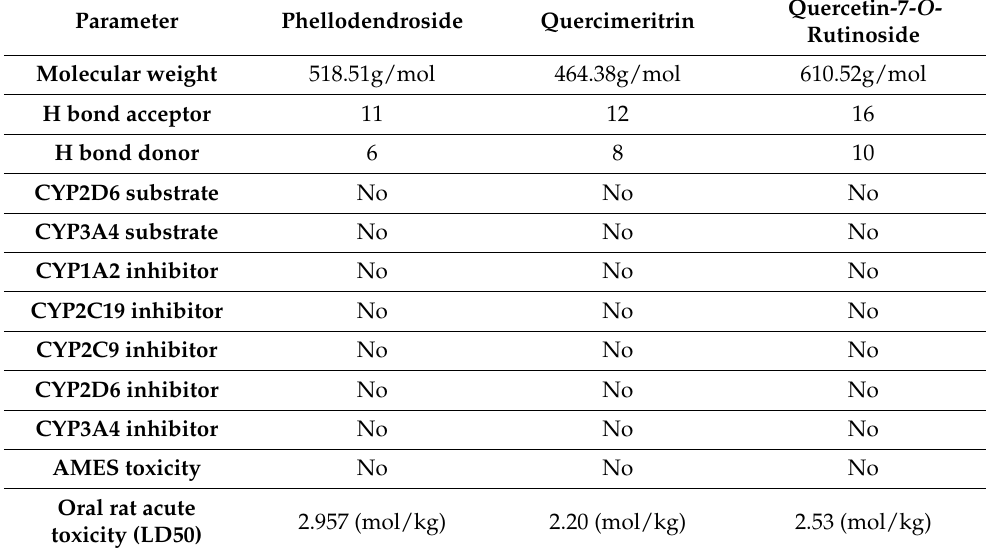
Table 2. The pharmacological and toxicity profiling of the screened compounds from SwissADME, ADMETSAR and PKCSM